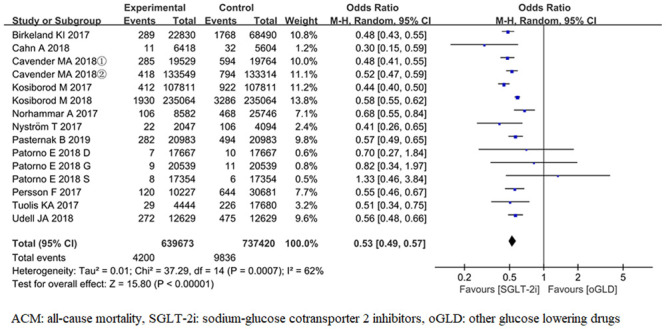
Forest plot of ACM for SGLT-2i and oGLD.